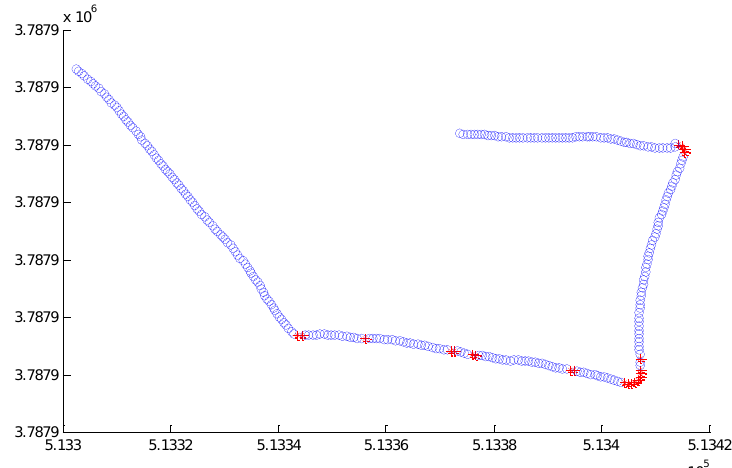
Figure 13. Analysis of the accumulated gyro value.